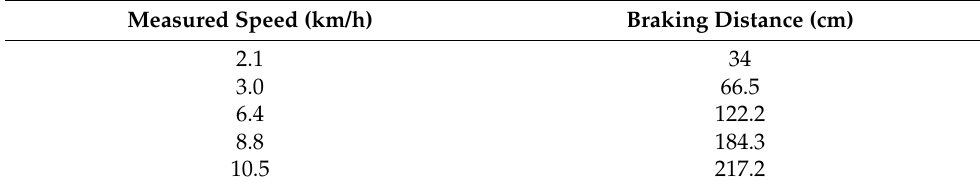
Table 1. Breaking distance according to the speed of the electric wheelchair.